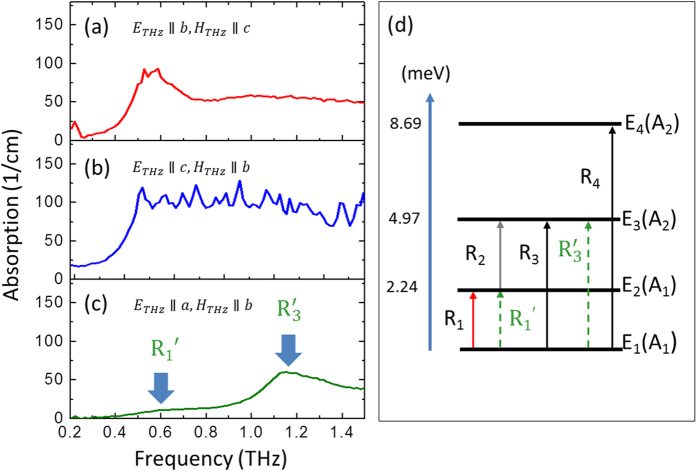
Absorption coefficient of TmFeO3 at 60 K with different excitation geometries (a) HTHz||c, ETHz||b in a-cut crystal, (b) HTHz||b, ETHz||c in a-cut crystal, and (c) HTHz||b, ETHz||a in c-cut crystal. (d) Energy diagram of ground multiplets of Tm ions.